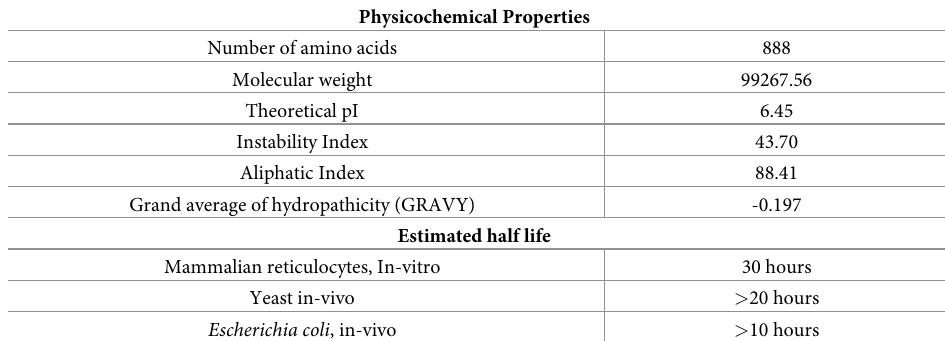
Table 5. Physicochemical properties of prodigiosin